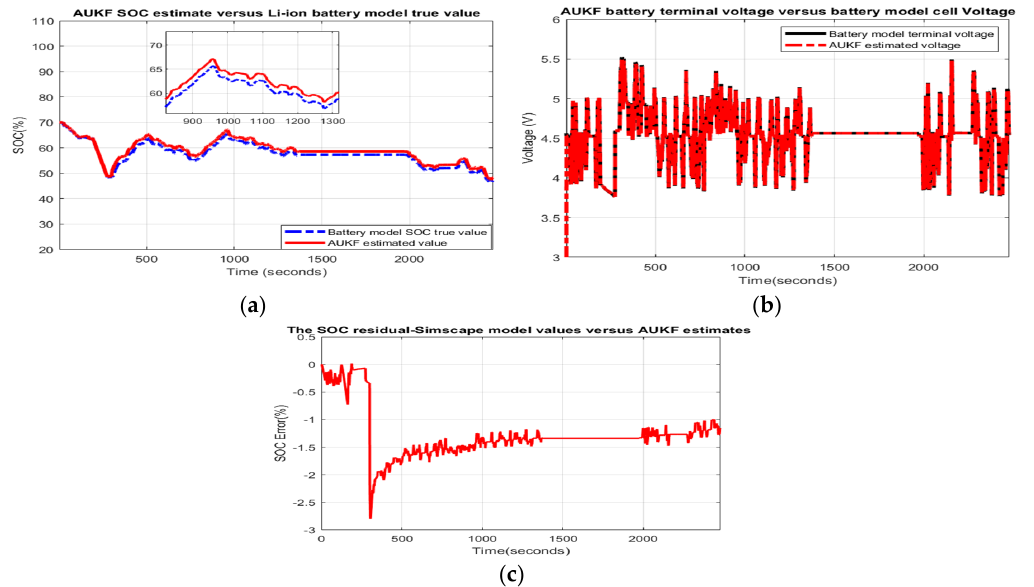
Figure A21. The MATLAB simulation results for Simulink Simscape Li-ion battery. ( a ) The AUKF SOC value versus battery model SOC true value; ( b ) The AUKF terminal output voltage versus battery model terminal output voltage true value; ( c ) The SOC residual.